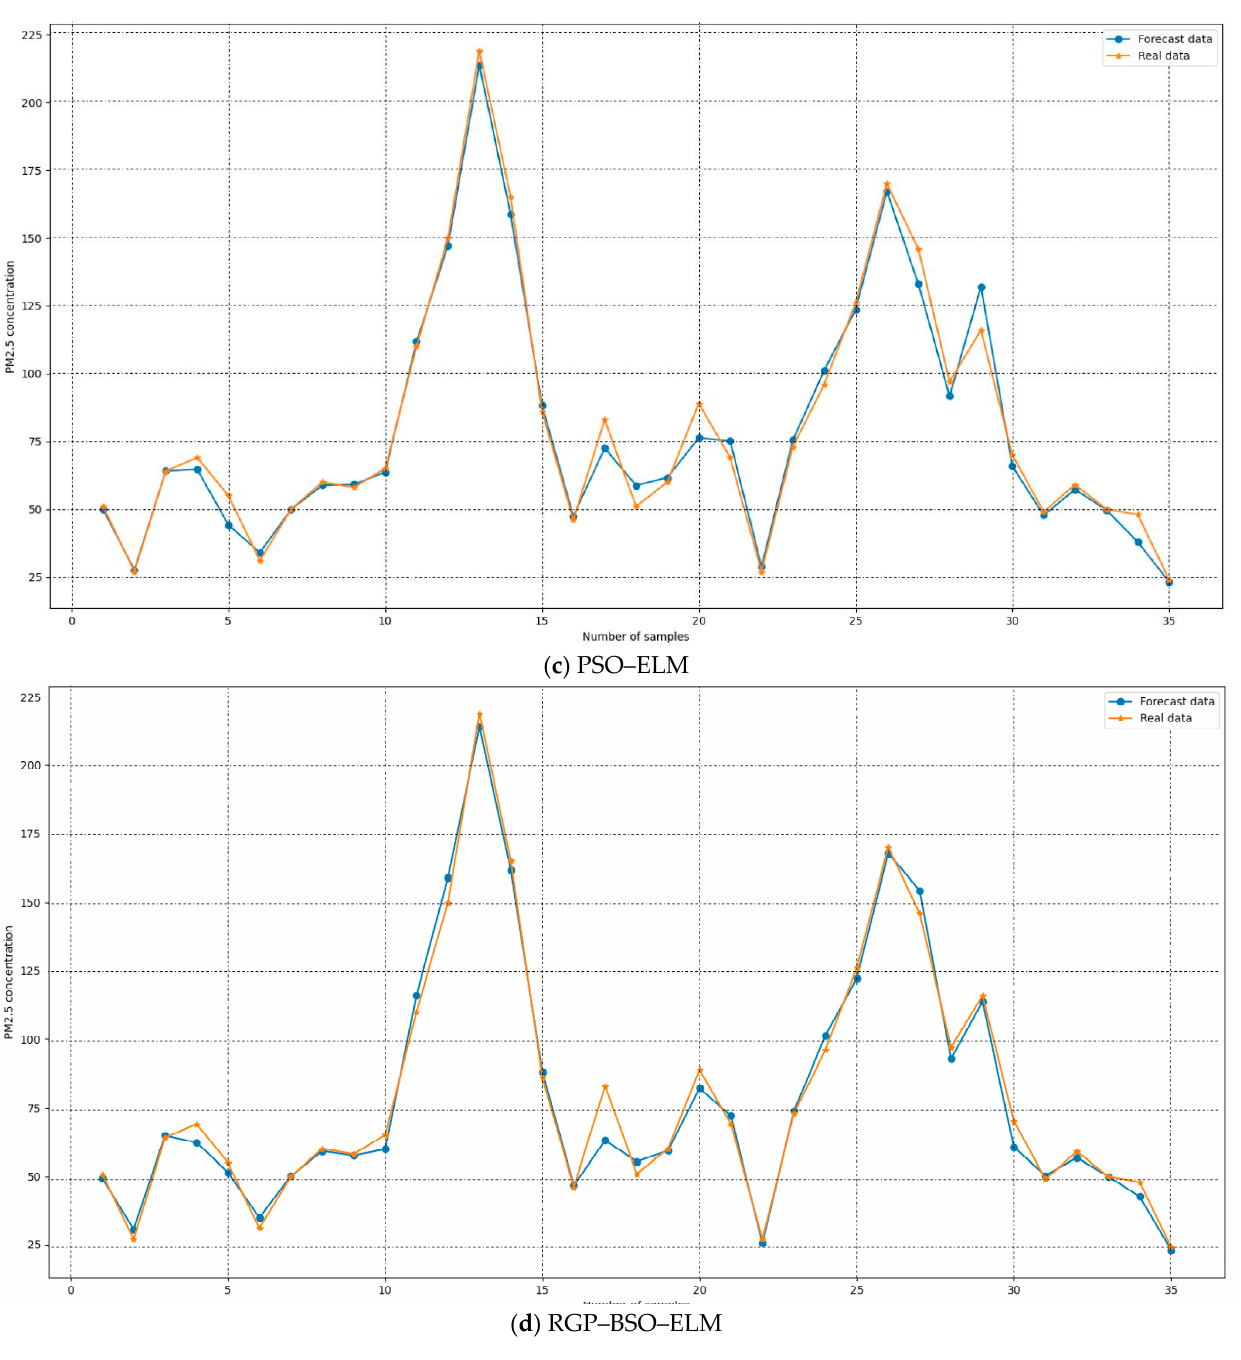
Figure 5. Prediction result graph. Table 3. Model evaluation index results.